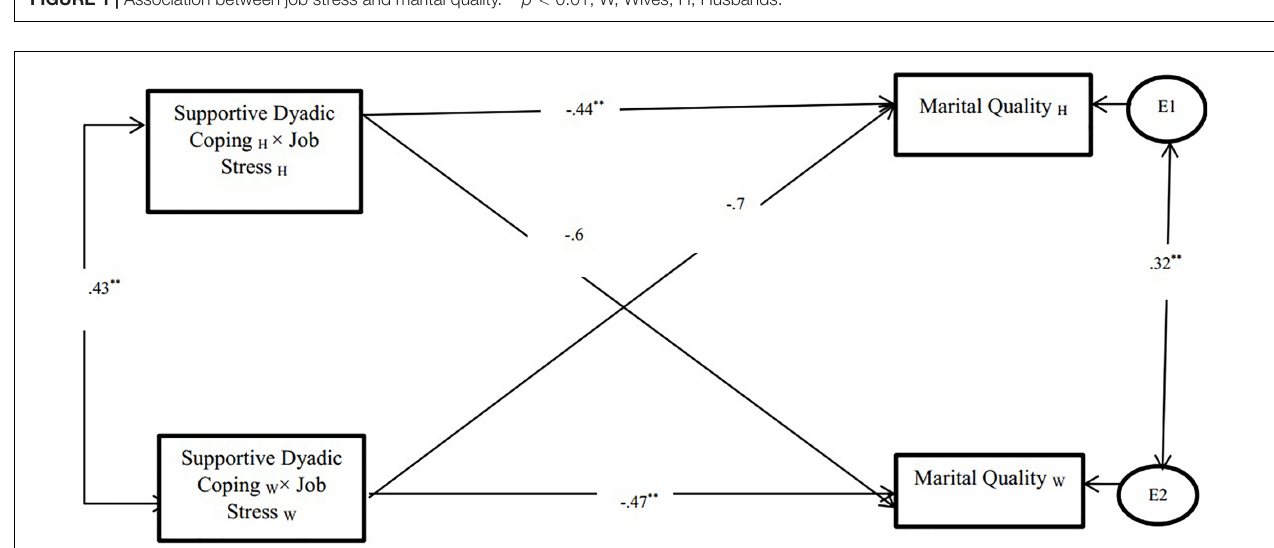
FIGURE 1 | Association between job stress and marital quality. ∗∗ p < 0.01; W, Wives; H, Husbands.